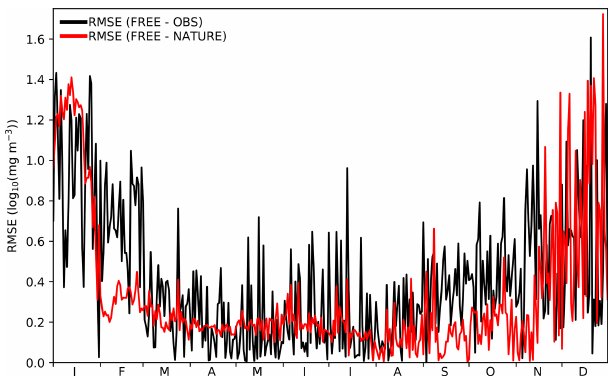
Figure 6. Time series of daily global RMSE for surface log 10 (Chl a ) between FREE and CCI ocean colour observations (black line) and between FREE and NATURE (red line) at CCI ocean colour observation